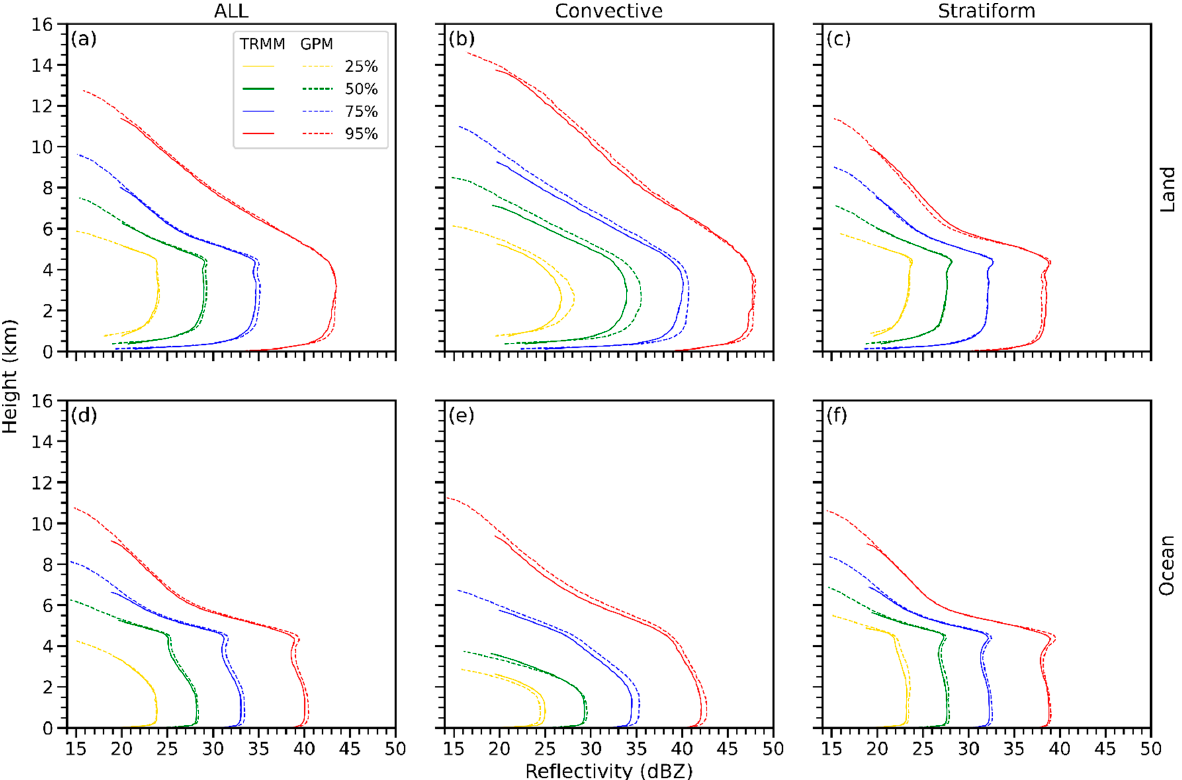
Figure 4. The coincident precipitation vertical profiles of reflectivity from the TRMM_PR (solid) and GPM_KuPR (dashed) in percentiles of 25% (yellow), median (green), 75% (blue), and 95% (red) over ( a – c ) land and ( d – f ) ocean. VPR are subdivided by ALL (first column), convective (second column), and stratiform (third column) rain types with a time interval of up to 15 min.